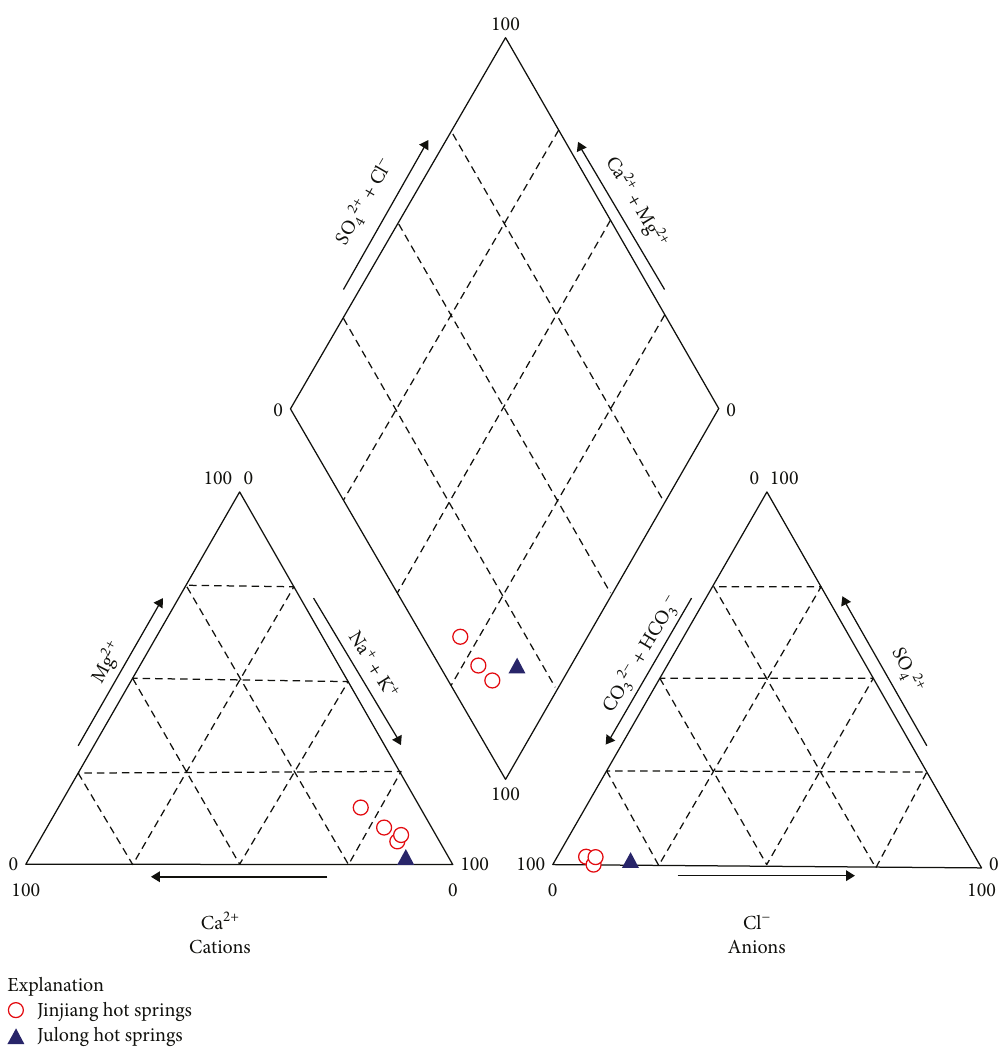
Figure 6: Piper diagram of sampled spring water. Table 3: The main gas compositions of hot spring water samples